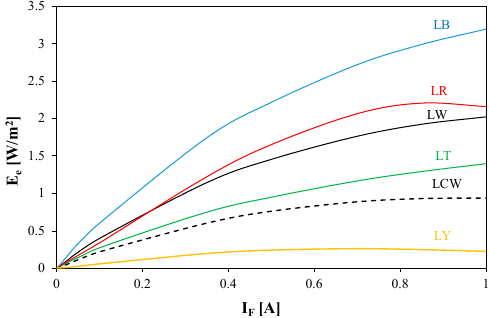
Figure 11. Measured dependences of the surface power density on forward current.